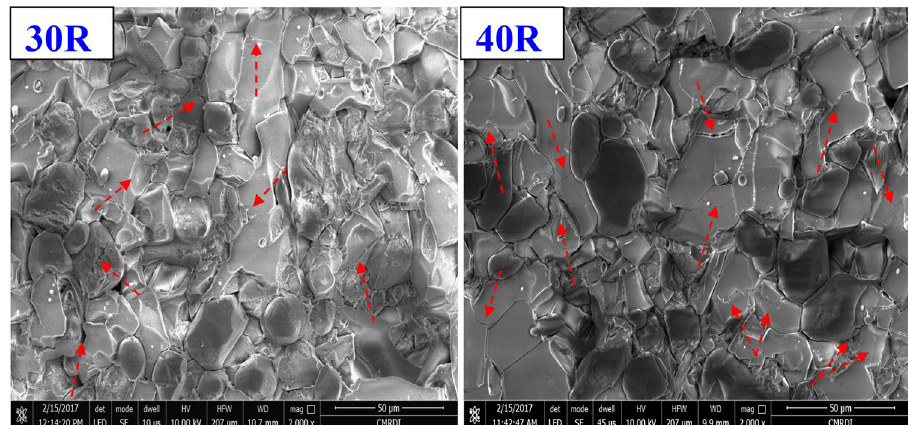
Figure 6. Microcracks distribution in sintered composites with high rutile content (30 and 40 wt%).